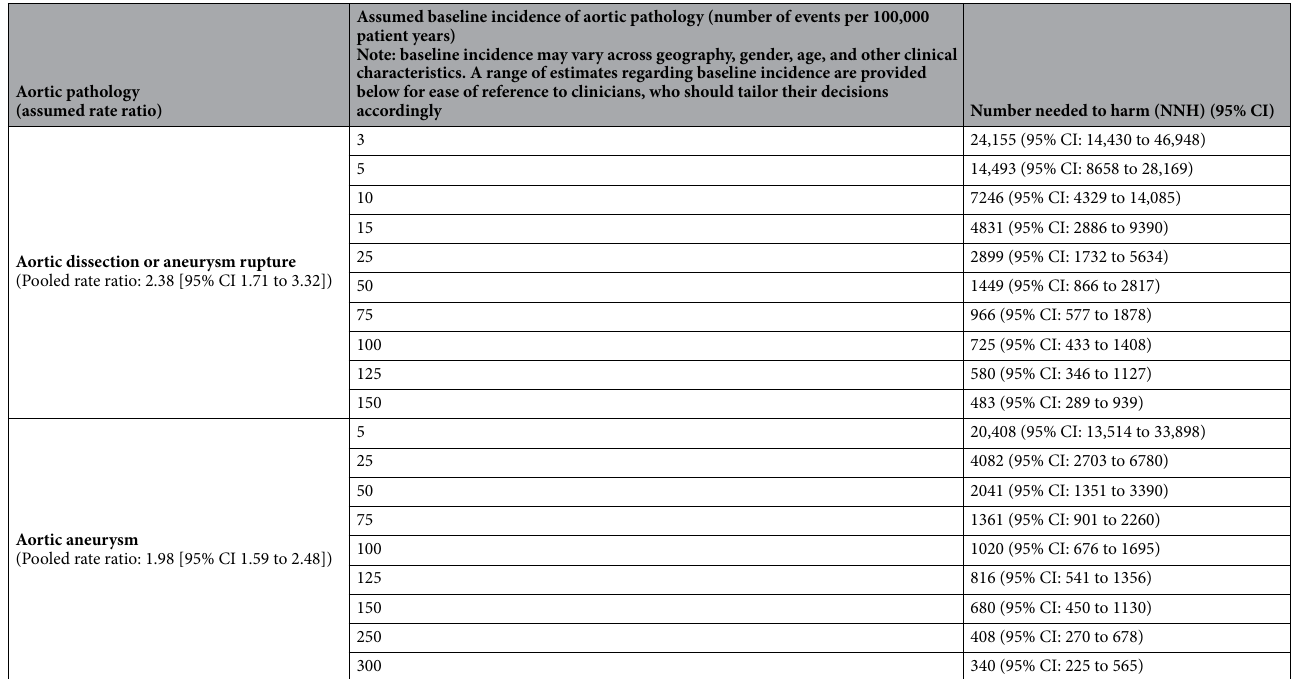
Table 2. Number needed to treat to harm for aortic